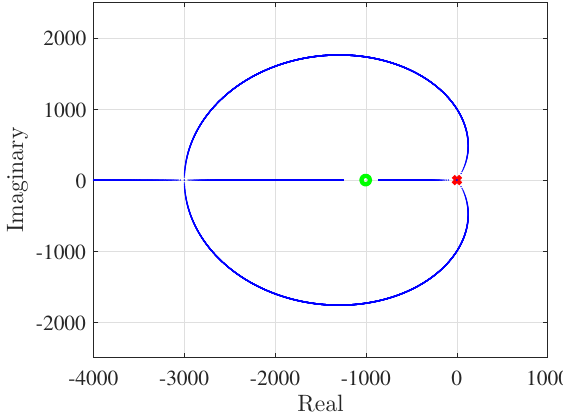
Figure 1. Root locus of (9) when n = 3 and α =